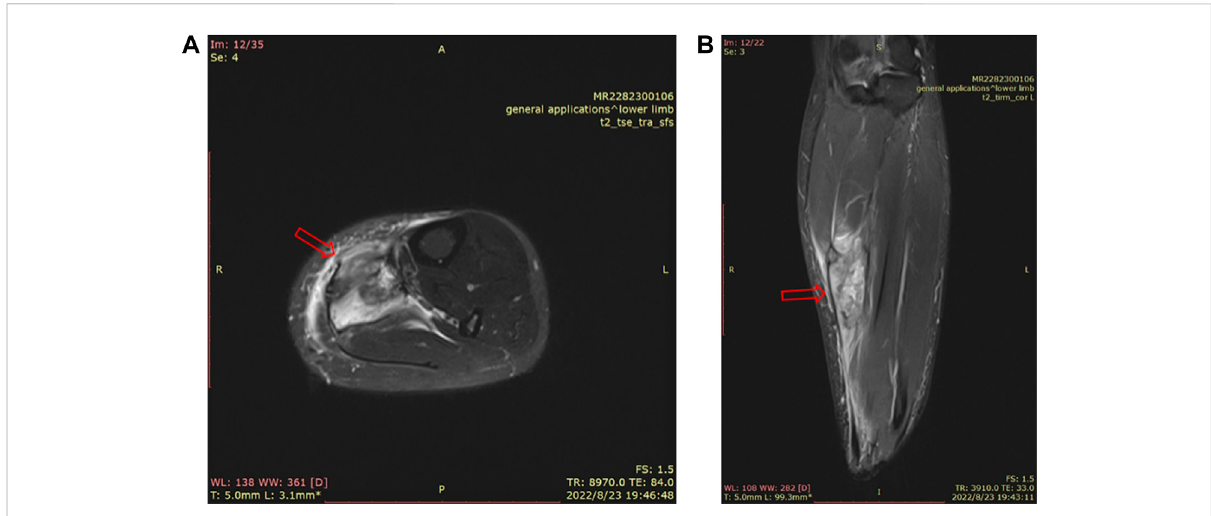
FIGURE 1 MRI of a 35-year-old female ’ s left calf. There is a mass-like high signal shadow in the fl ounder and posterior tibial muscles, a small amount of fl uid in the intermuscular space, thickening and swelling of the surrounding fascia, and edema in the subcutaneous fat layer (A) . MRI image of the cross section of the left calf. (B) . MRI image of the sagittal plane of the left